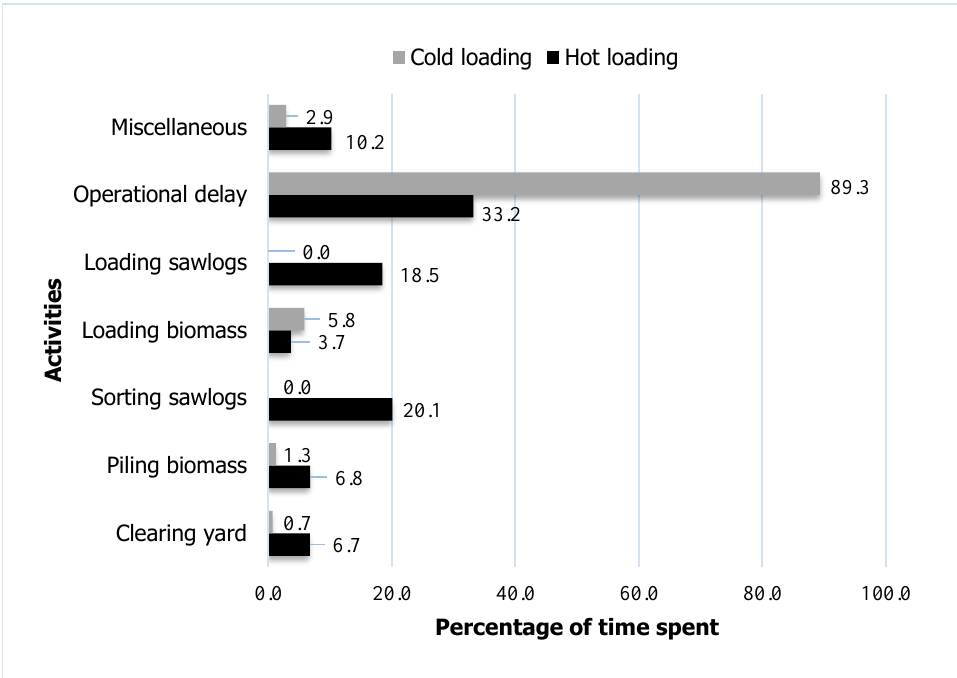
Figure 5. Distribution of tasks for the loader developed from the task sampling method for hot and cold loading arrangements. Miscellaneous is comprised of mechanical and personal delays.